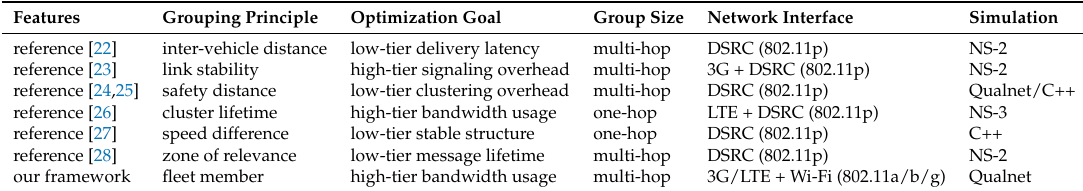
Table 1. Comparison of existing clustering mechanisms [22–28] and our